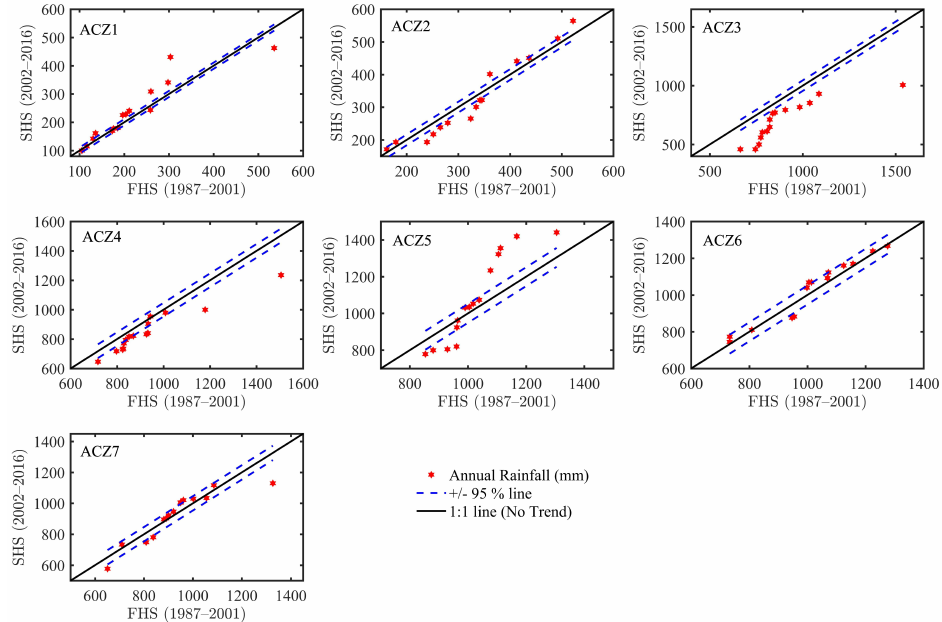
Figure 10. Annual rainfall trend using the ITA